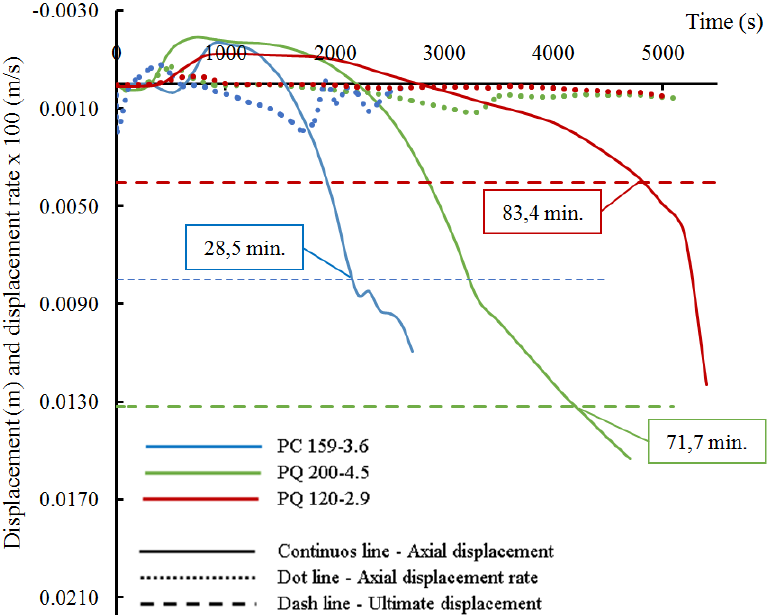
Figure 17. Fire resistance time for specimen 1, 2 and